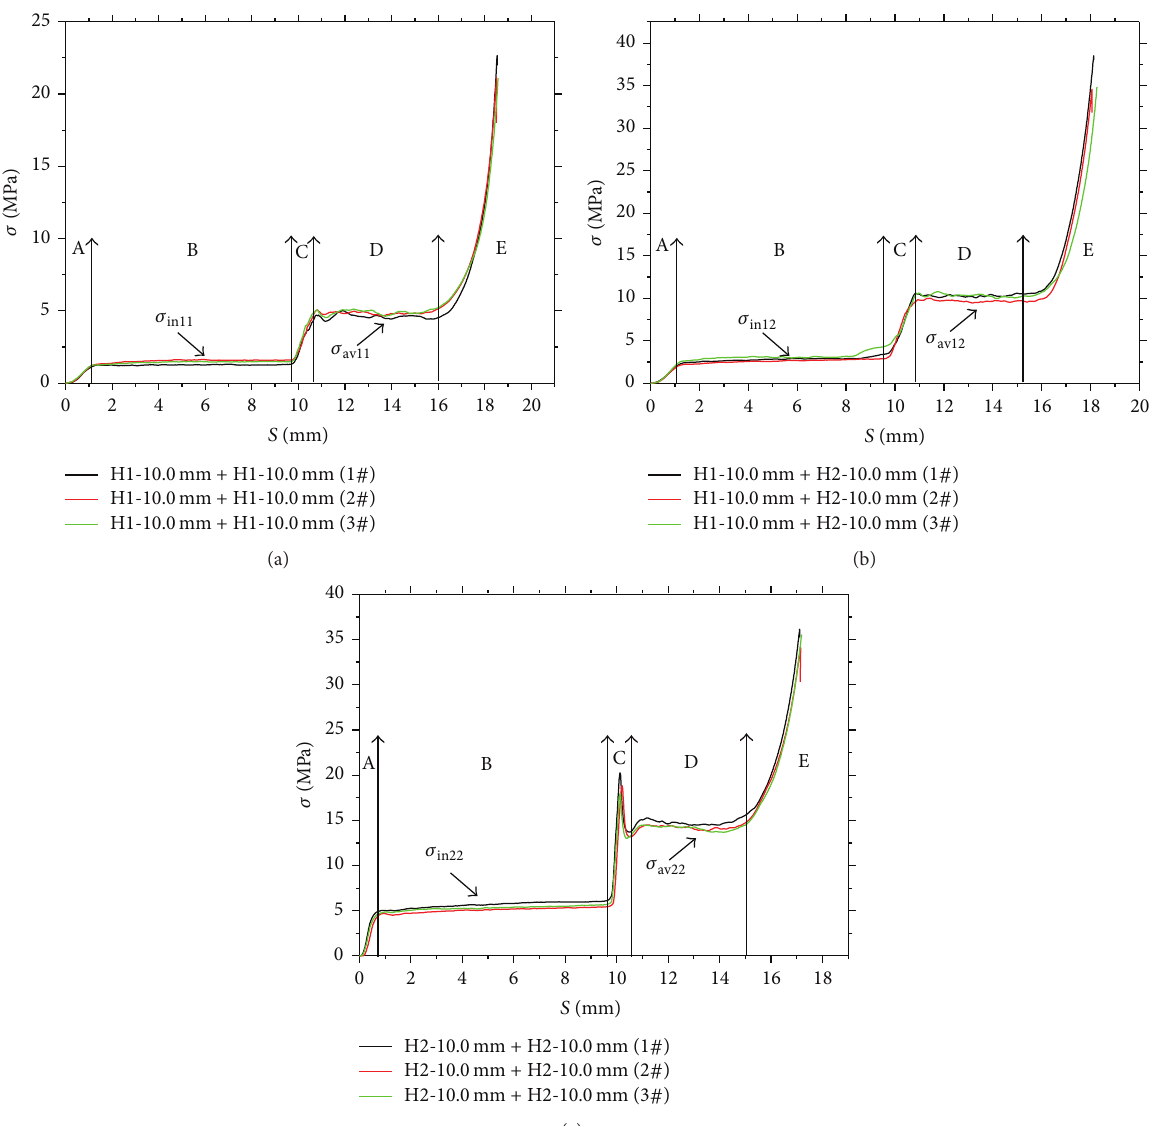
Figure 4: Compressive mechanical curves of two stack-up CHAH samples. (a) H1-10mm + H2-10mm, (b) H1-10mm + H2-10mm, and (c) H2-10mm + H2-10